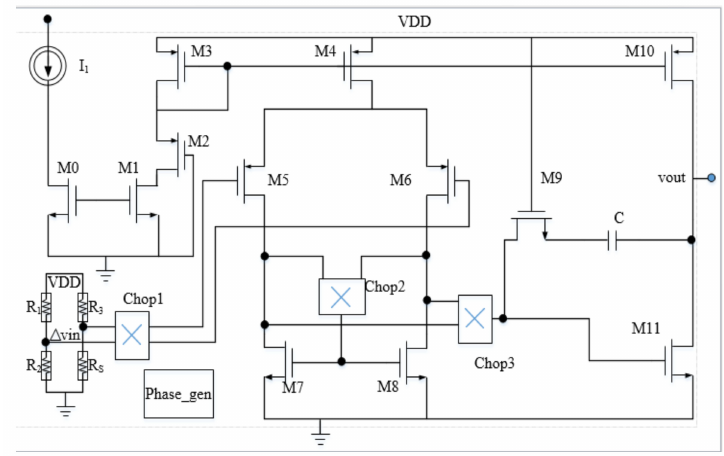
Figure 3. Schematic of low noise chopper operational amplifier